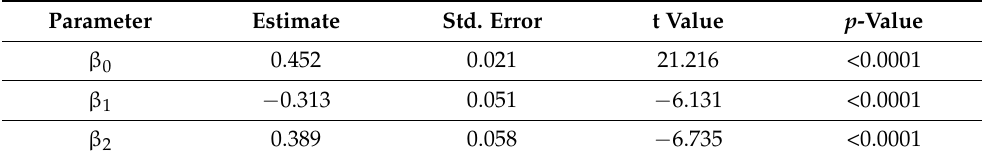
Table A1. Linear mixed effect model for hardness—summary statistics of the fixed effects. p -values are approximated using the Satterthwaites’s method [20], AIC = 2446.566, and standard deviation of the random effect equals 0.052.